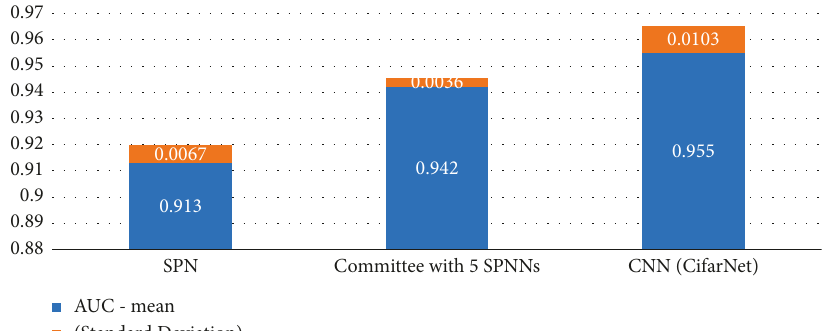
Figure 3: Comparison of performance in terms of AUC for the deep learning models addressed: SPNN, committee with 5 SPNNs, and